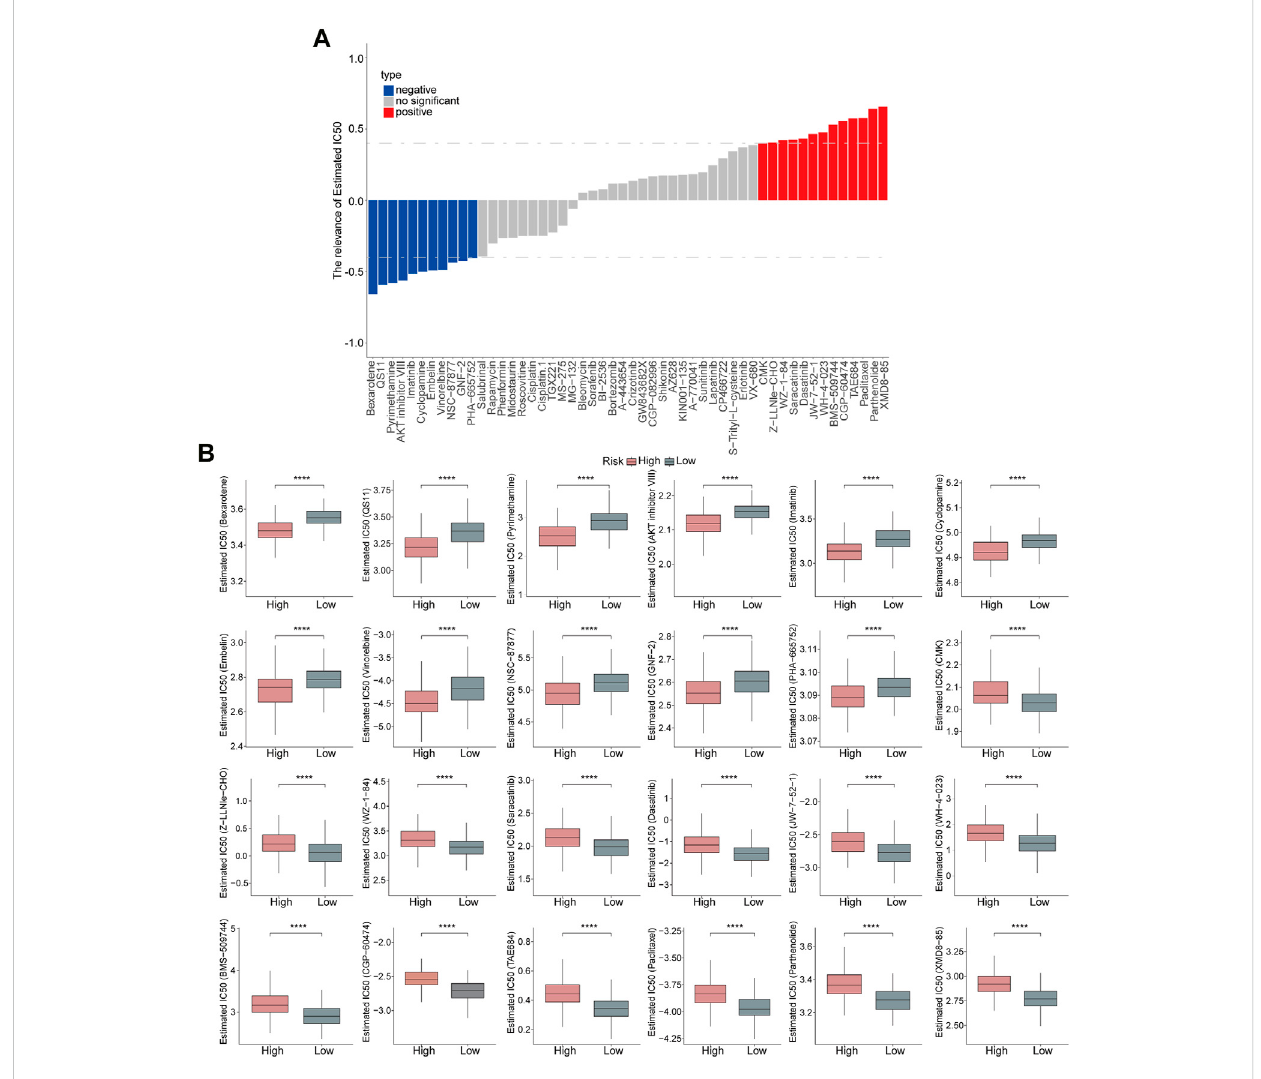
FIGURE 8 Evaluation of the risk model on drug sensitivity. (A) Correlation analyses between risk score and chemotherapeutic drugs are shown in the Histogram. (B) Estimated IC50 values of chemotherapeutic drugs between the high- and low-risk groups. p <